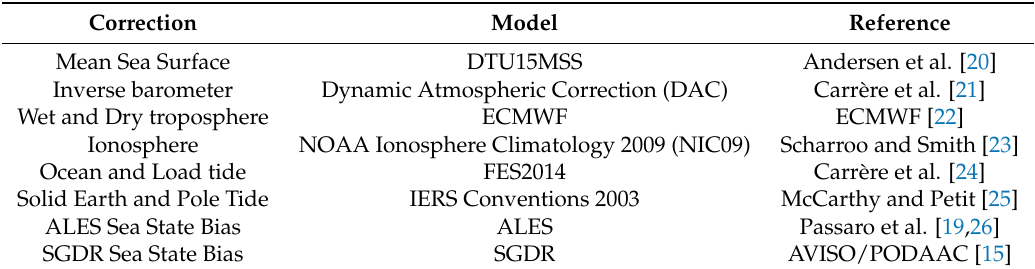
Table 1. List of corrections used to compute Sea Level Anomalies for this